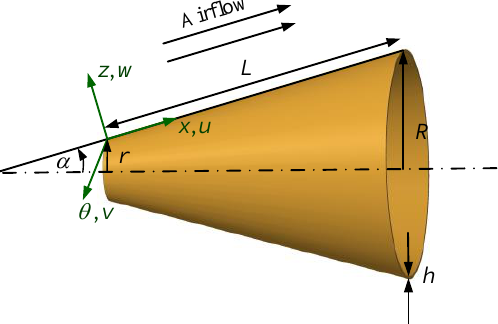
Figure 1. Schematic diagram of conical shell in supersonic flow.